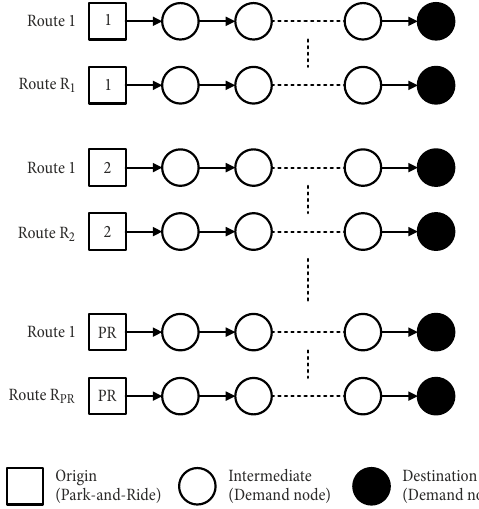
Fig. 2. Representation scheme of the GA-based